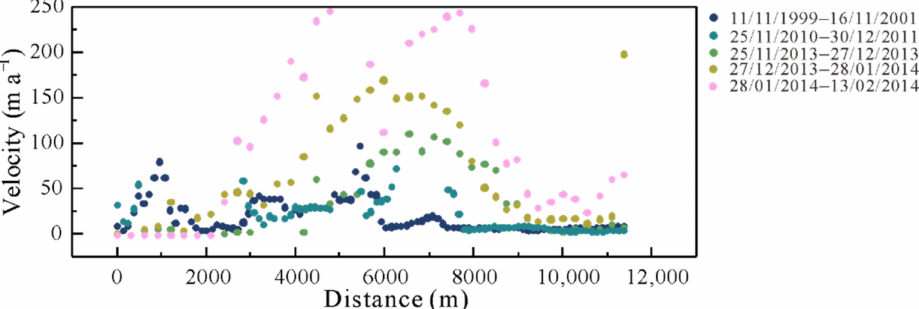
Figure 6. Velocities of the quiescent period (1999–2001 and 2010–2011) and the initiation during the winter of